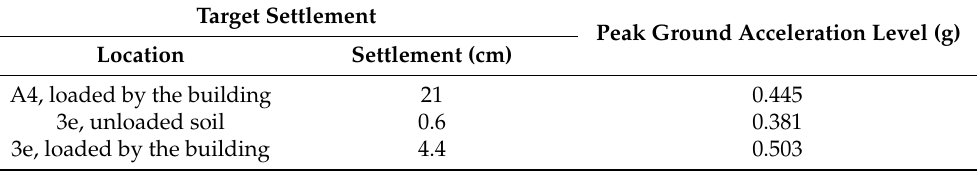
Table 3. Results of